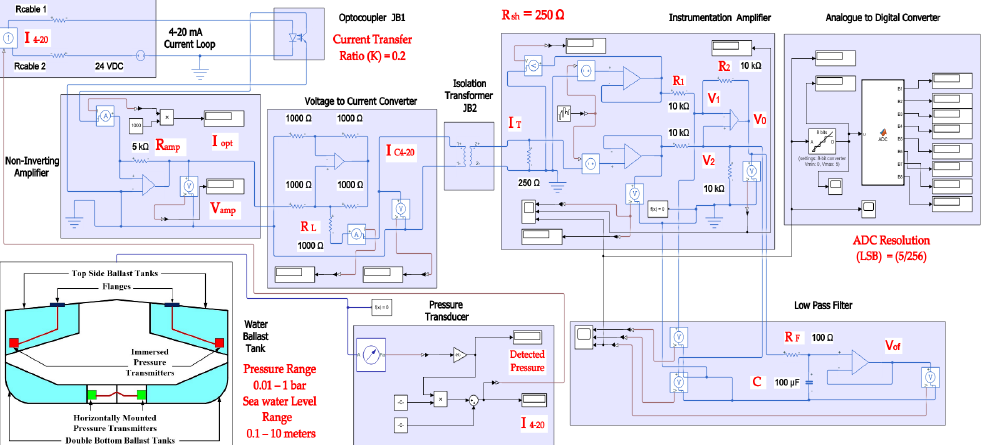
Figure 4. Simulink Simscape model used to simulate 4 – 20 mA pressure measurement current loop as a part of automation system.